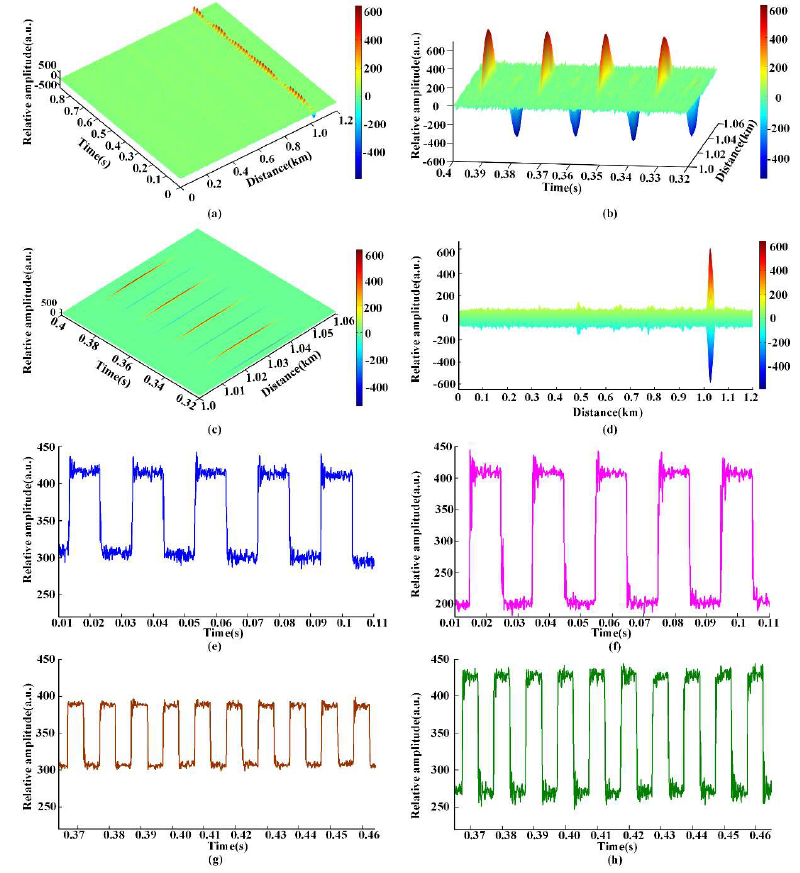
Figure 7. Square wave signal test: ( a ) 3D plot of the intensity variation under 50 Hz square wave signal; ( b ) partially enlarged view of the intensity variation under 50 Hz square wave signal; ( c ) top view of the intensity variation under 50 Hz square wave signal; ( d ) superimposed differential signal under 50 Hz square wave signal; ( e ) extracted vibration waveform under 50 Hz 5 V pp square wave signal; ( f ) extracted vibration waveform under 50 Hz 10 V pp square wave signal;( g ) extracted vibration waveform under 100 Hz 5 V pp square wave signal; ( h ) extracted vibration waveform under 100 Hz 10 V pp square wave signal.